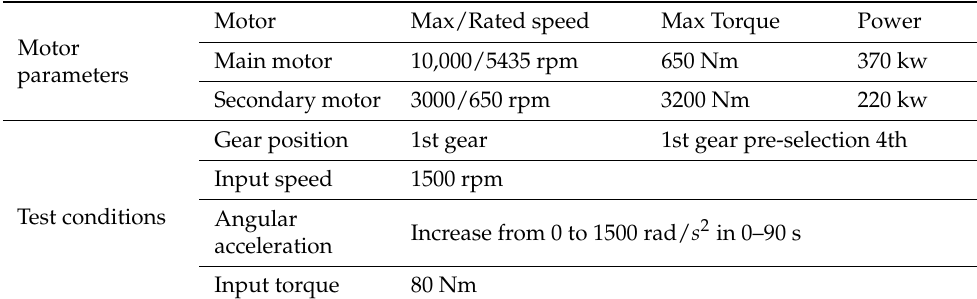
Figure 7. Transmission test bench and speed sensor installation position. Table 2. Motor parameters and test conditions.